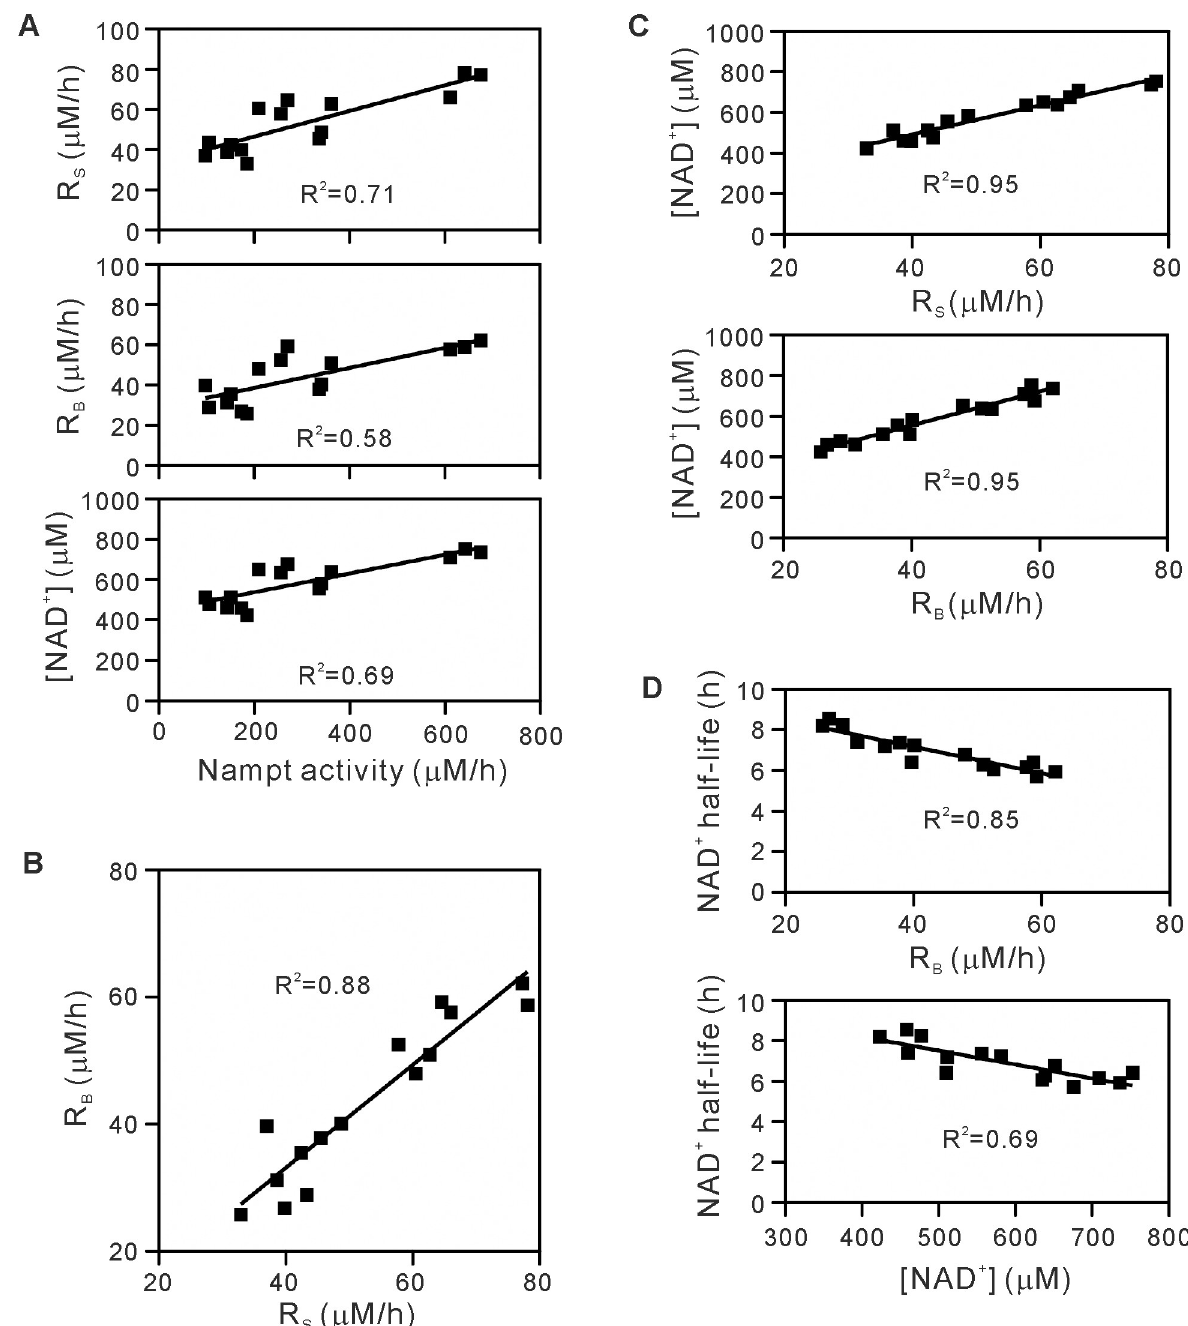
Fig 6. The effects of induced expression of Nampt on R S , R B , cellular NAD + concentration, and half-life of NAD + . Nampt expression was induced in HeLa cells by incubating with 0.1, 0.2, 0.3, or 1.0 μ g/mL of Dox. (A) Relation of R S , R B , and cellular NAD + concentration to total Nampt activity. (B) Relation between R S and R B . (C) Relation of cellular NAD + concentration to R S or R B . (D) Relation of NAD + half-life to R B or the NAD + concentration. Determination coefficience (R 2 ) is also